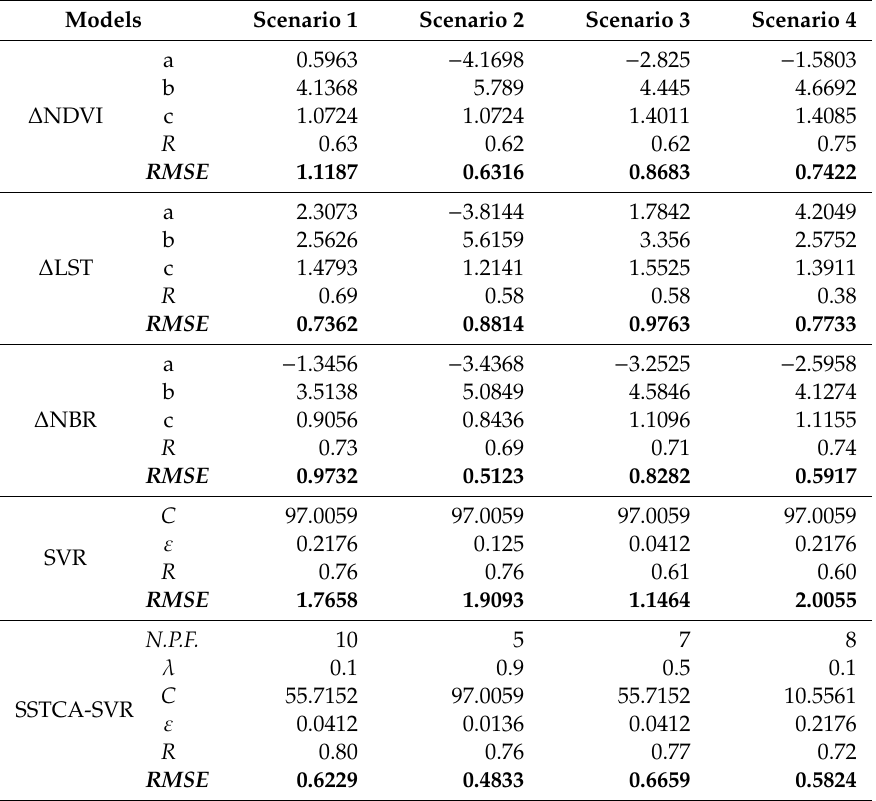
Table 4. Accuracies of mapped results in di ff erent